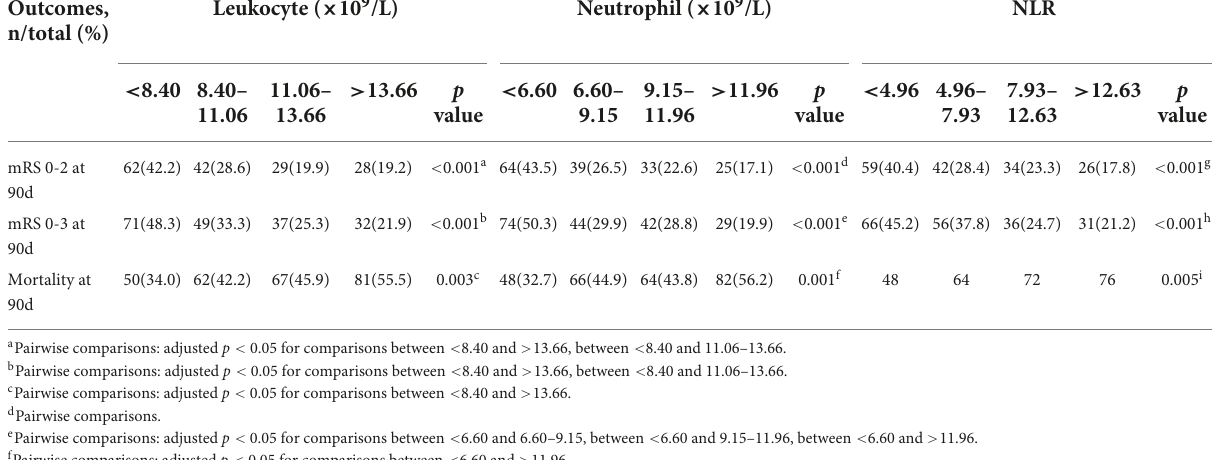
TABLE 1 Clinical outcomes of patients undergoing EVT according to quartiles of leukocyte counts ( × 10 9 /L), neutrophil counts ( × 10 9 /L), and NLR. Outcomes, n/total